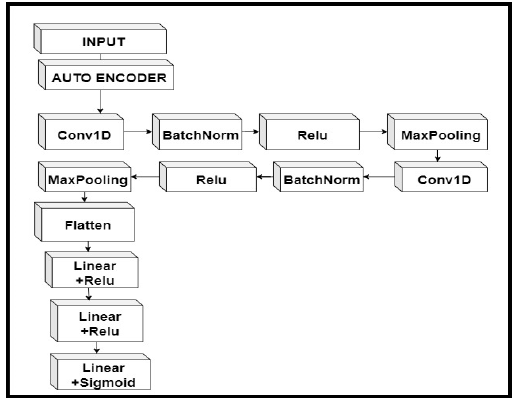
Figure 8. The hybrid model of an autoencoder and convolutional neural network (CNN).